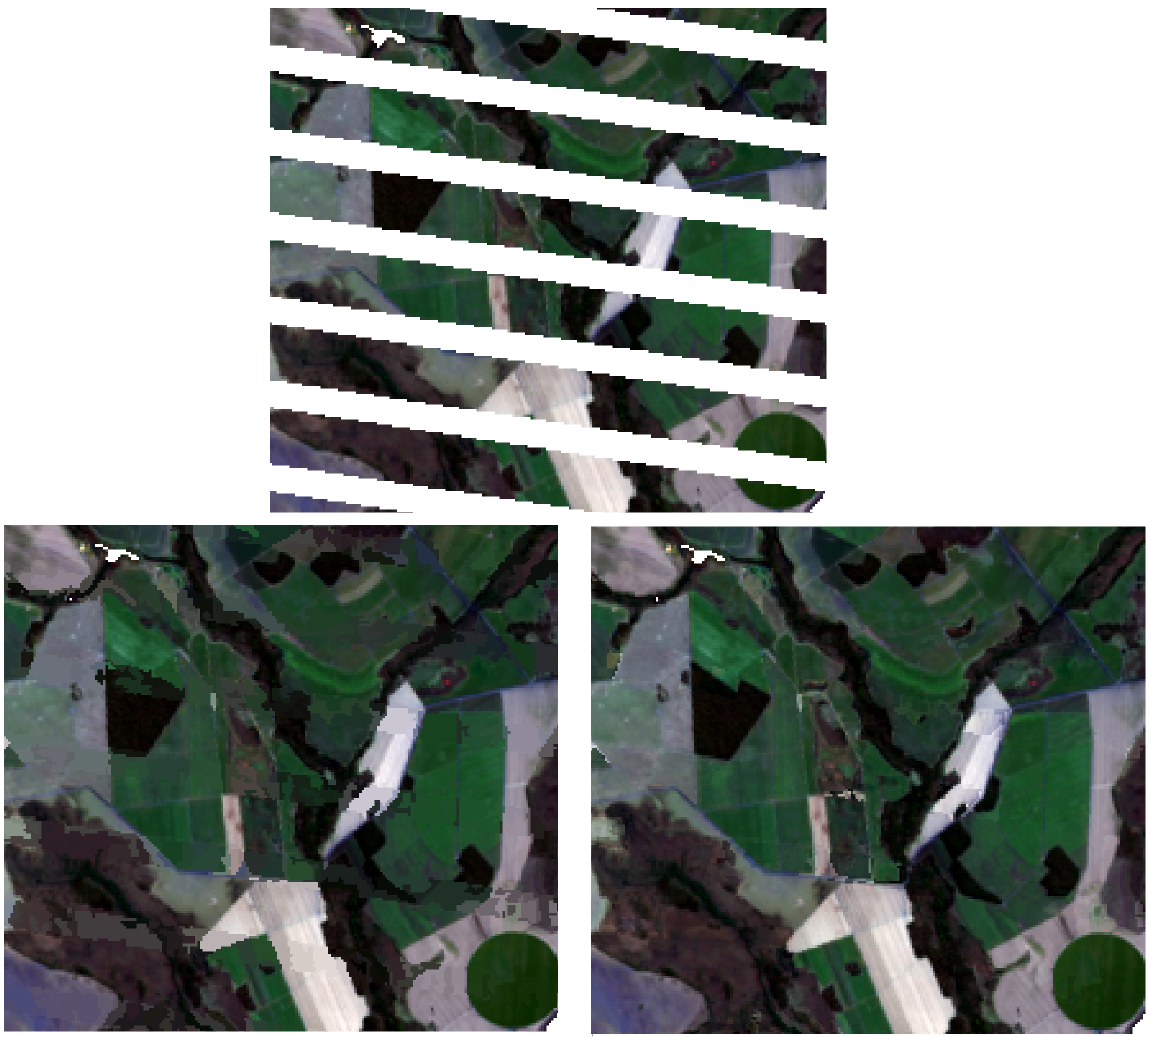
Figure 3: SLC-off Landsat-7/ETM+ image (upper image); image filled through Maxwell et al. (2007) hierarchical multi-scale segmen- tation method (bottom left image) and the image filled through the proposed method, which uses segmentation pixel weighting (bottom right